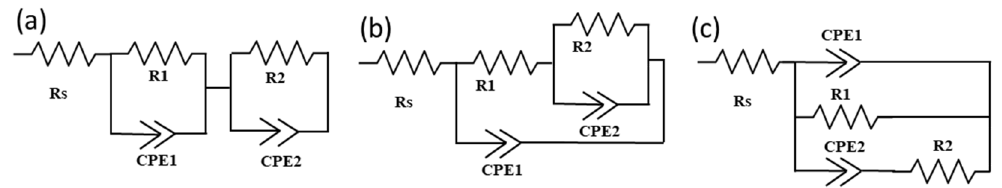
Figure 5. Electrical equivalent circuits used for impedance spectra modeling representing two-time constants in the Nyquist plot: ( a ) Voight circuit; ( b ) ladder-type circuit (Matryoshka); and ( c ) Maxwell circuit.